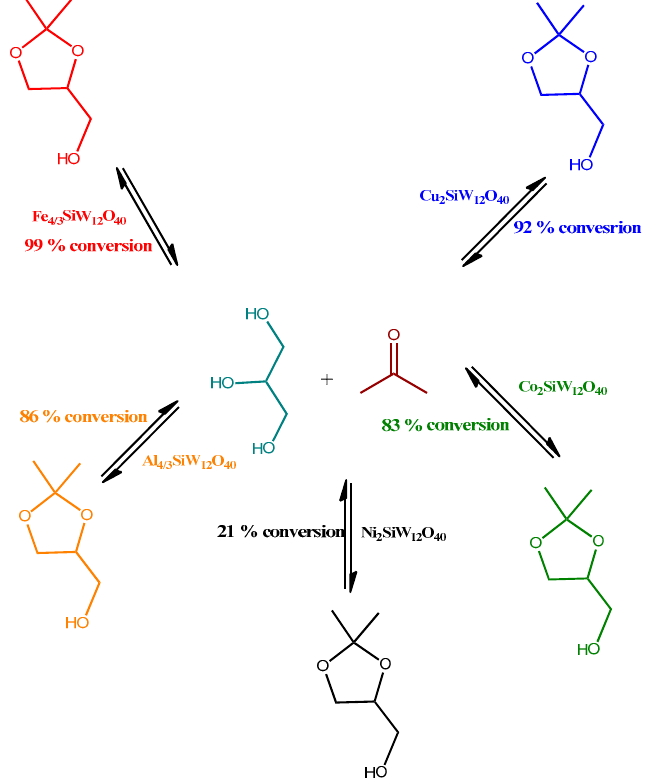
Figure 29. Synthesis of solketal catalyzed by metal-exchanged silicotungstic acid salts (adapted from ref. [73]).